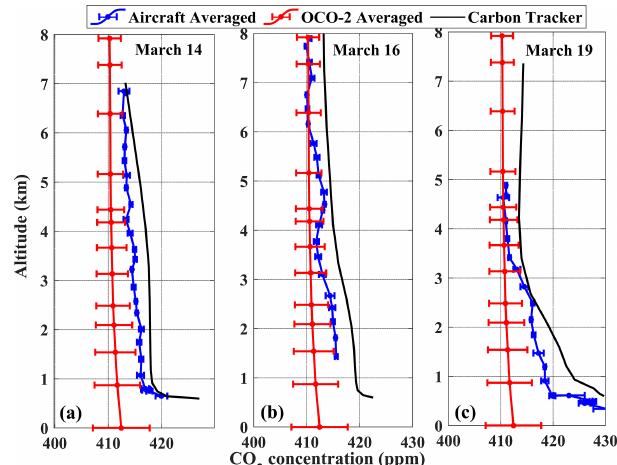
Figure 19. CO 2 volume mixing ratio profile comparison results of airborne greenhouse gas analyser and OCO-2 satellite, Carbon- Tracker model. Panel (a) is the vertical structure of CO 2 volume mixing ratio on 14 March. Panel (b) shows the vertical structure of CO 2 volume mixing ratio on 16 March. Panel (c) shows the vertical structure of CO 2 volume mixing ratio on 19 March. The red error bars represent the inversion result of OCO-2. The blue error bars represent the measurement result of the airborne greenhouse gas analyser. The black solid line is the result of CarbonTracker